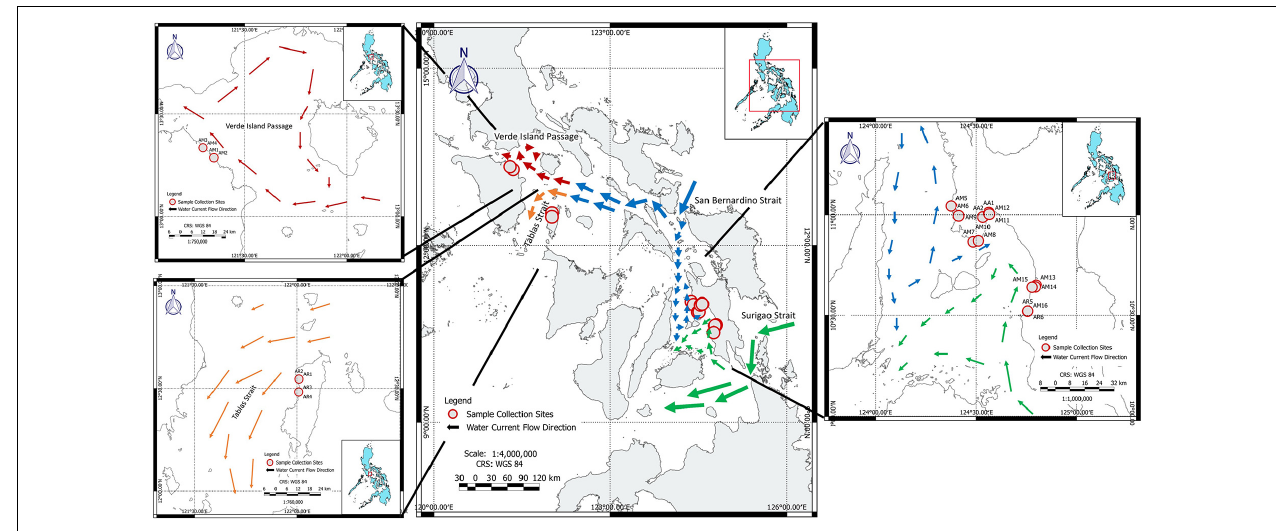
FIGURE 1 | Overview of the studied areas in The Philippines with detailed maps of sampled Avicennia marina (AM), A. rumphiana ( AR), and A. alba (AA) collection sites. Population codes are denoted as in Table 1 and in Supplementary Figure 1 with images of all estuaries. Principal ocean currents of the study area are indicated by different arrow lengths, conceptually indicating the strength of currents. Note the weak ocean currents of Western Leyte (Modified from May et al.,